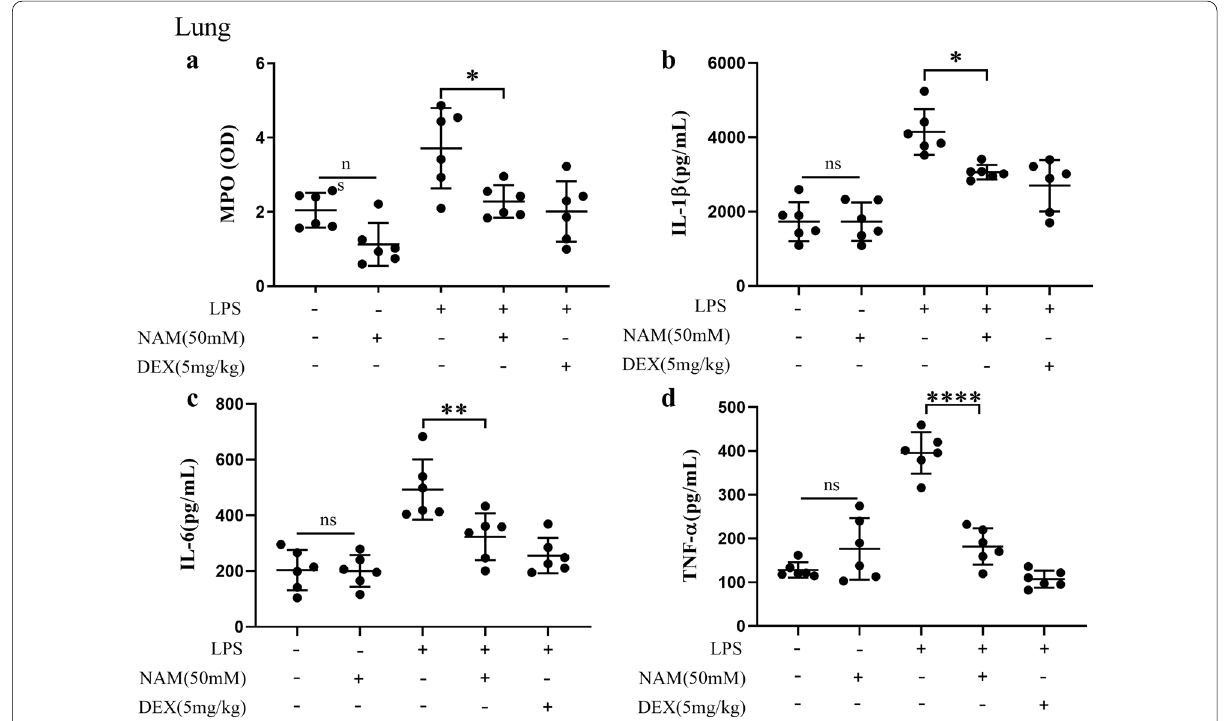
Fig. 3 The expression of MPO and pro-inflammatory mediators in lung. a MPO activity test results. b – d The protein levels of IL-6, IL-1β and TNF-α. The values are presented as the mean SD (* p < 0.05, ** p < 0.001, *** p < 0.001 and **** p < ±